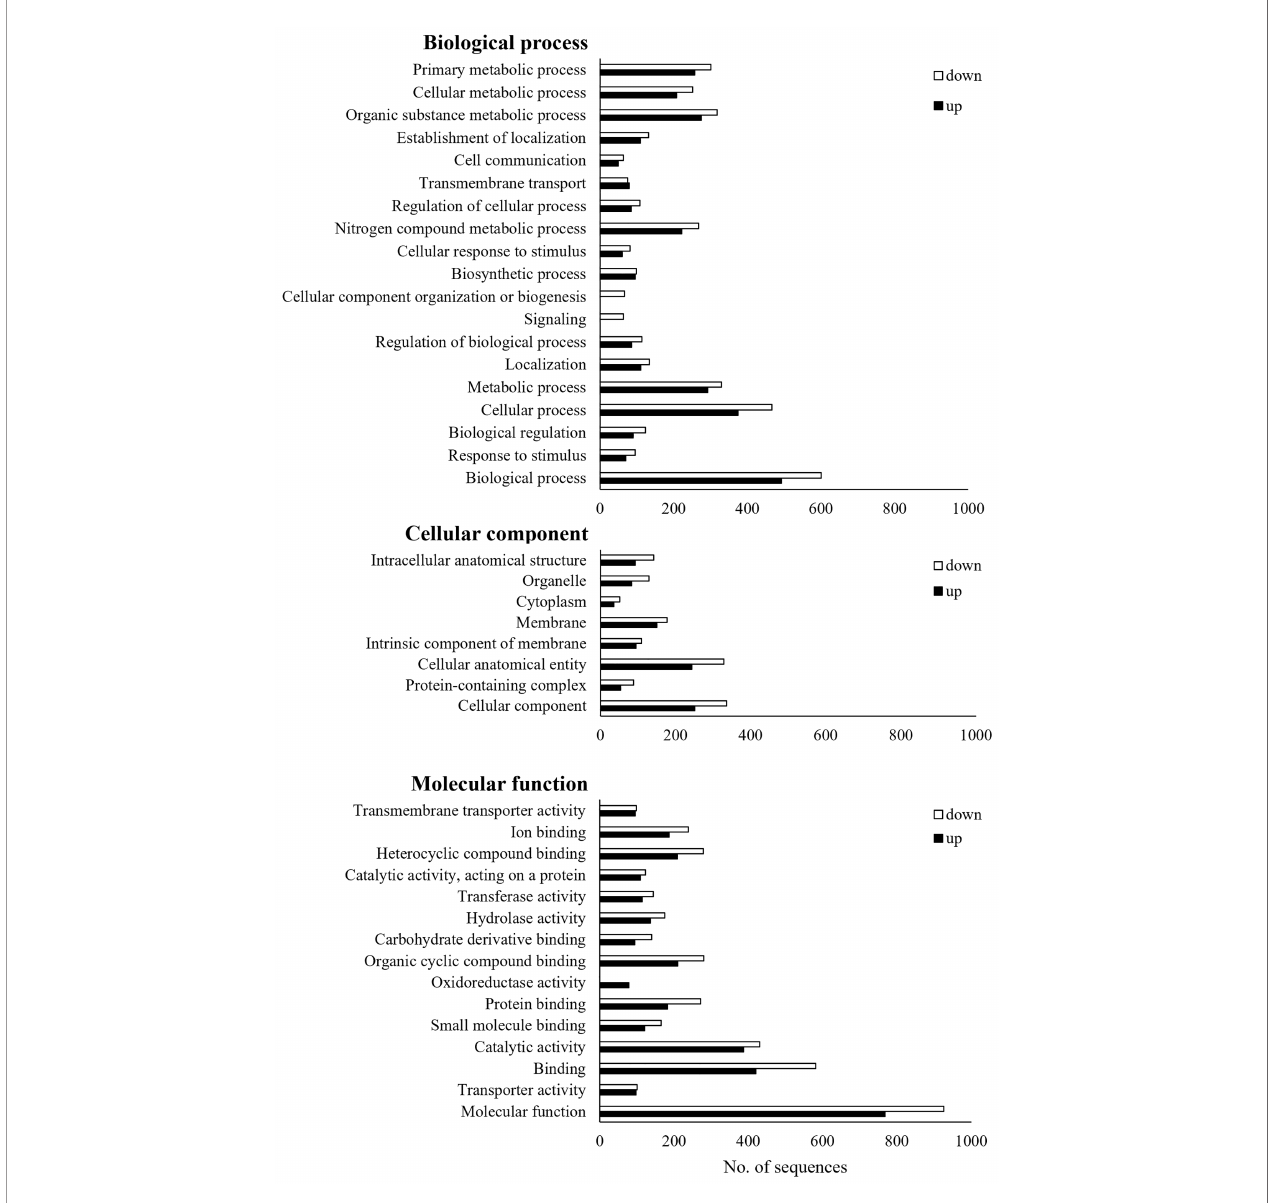
FIGURE 3 | Gene ontology (GO) analysis of JEF-544-infected aphid. DEGs of JEF-544-infected aphids were classi fi ed into three main categories (biological process, cellular component, and molecular